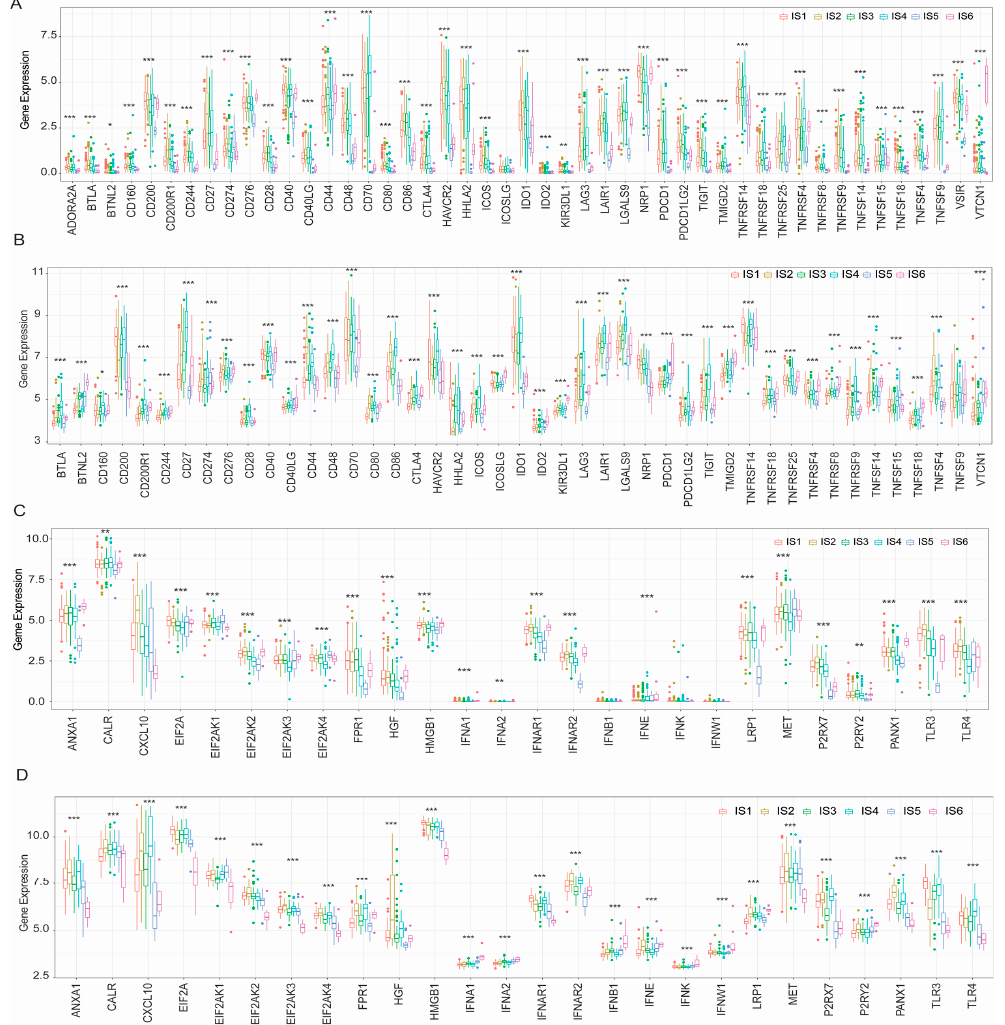
Figure 7. Correlation between tumour immune subtypes and ICP and ICD genes. The expression of ICP genes between different immune subtypes of KIRC in the TCGA ( A ) and GEO ( B ) cohorts. In the TCGA ( C ) and GEO ( D ) cohorts, ICD-regulated genes were differentially expressed in immune subtypes of KIRC. (* p < 0.05, ** p < 0.01, *** p < 0.001). Immune checkpoint (ICP); Immunogenic cell death (ICD); Kidney renal clear cell carcinoma (KIRC); The Cancer Genome Atlas (TCGA); Gene Expression Omnibus (GEO).